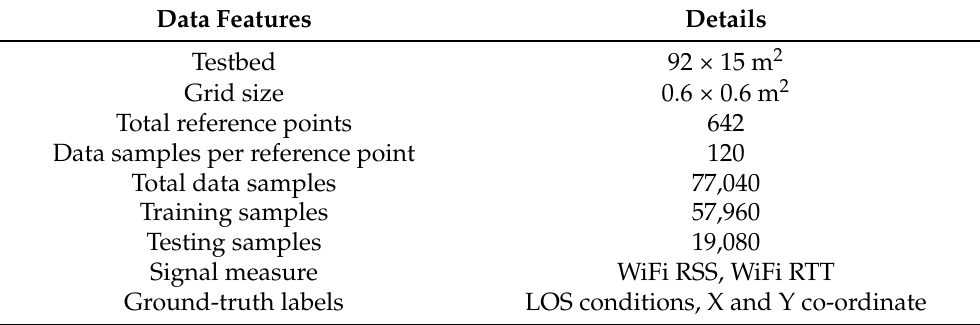
Table 2. Summary of our dataset.